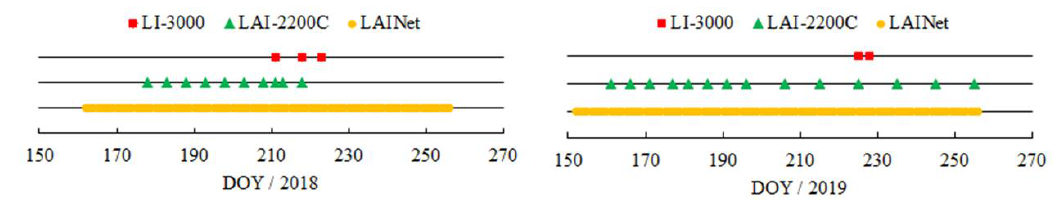
Figure 2. Temporal distribution of in situ leaf area index (LAI) measurement using three instruments during the 2018 and 2019 seasons. DOY stands for day of year (for instance, DOY 210 is the 210th day of this year).